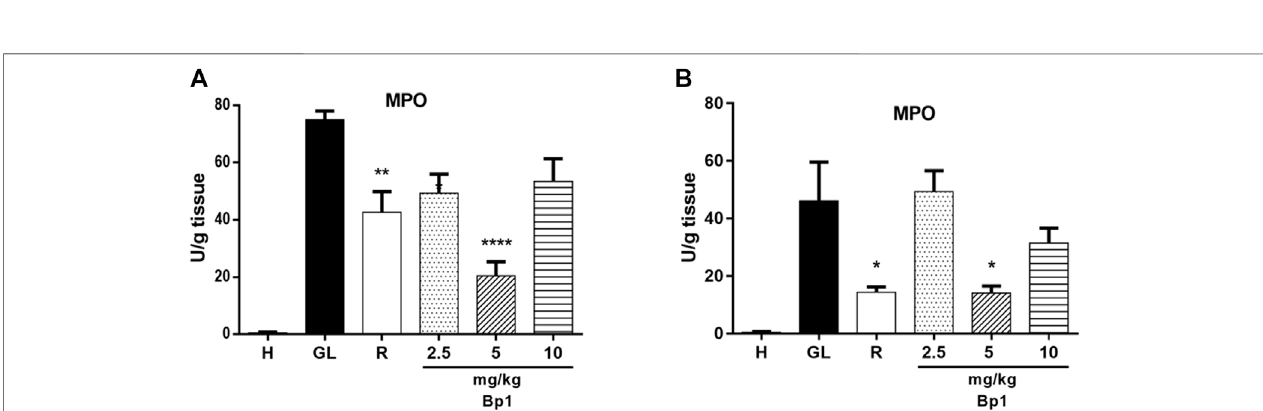
FIGURE 13 | Effect of pretreatment with Bp1 (2.5, 5, and 10 mg/kg) on MPO enzyme activity in the gastric mucosa homogenate of lesions in mice (A) ethanol- induced and (B) indomethacin-induced. Results expressed as mean ± standard mean error ( n (cid:2) 7). ANOVA and Tukey post-test were used to calculate the statistical signi fi cance, * p < 0.05, ** p < 0.01, and **** p < 0.0001 vs. gastric lesion control. Healthy, H; gastric lesion control, GL; ranitidine (50 mg/kg), R.